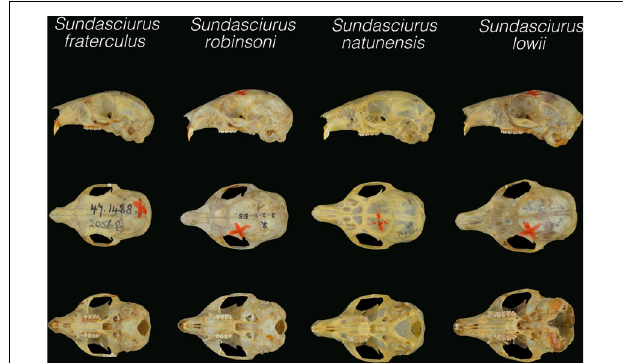
FIGURE 6 | Dorsal, palatal, and lateral views of the holotype skulls of Sundasciurus lowii (NHM76.5.2.14), Sundasciurus natunensis (NHM94.9.28.40) and Sundasciurus robinsoni (NHM3.2.6.55). Given the highly damaged state of the holotype skull of Sundasciurus fraterculus (NHM95.1.9.12), the type of Sundasciurus fraterculus siberu (NHM47.1488) is shown instead for the sake of comparison. All pictures are at the same